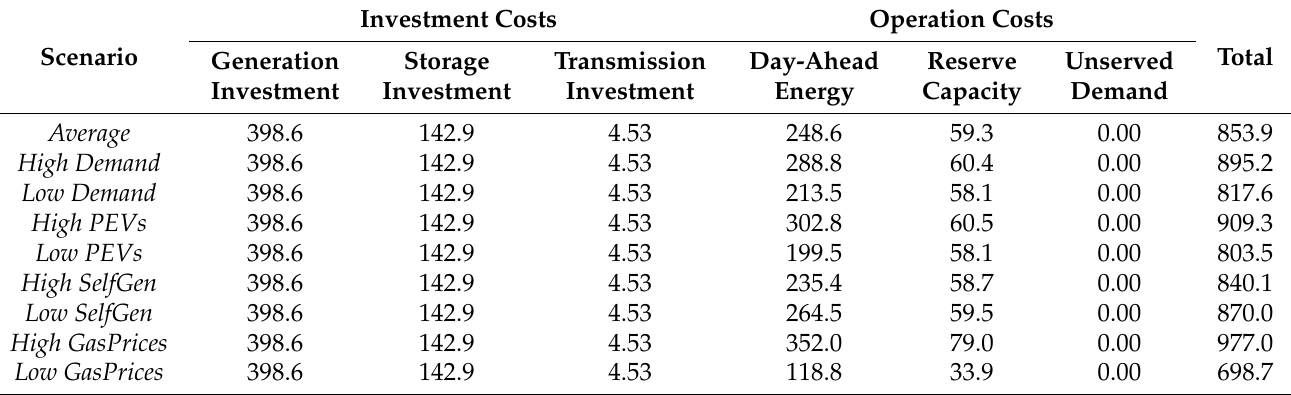
Table 18. Cost per operation-related scenario (million e